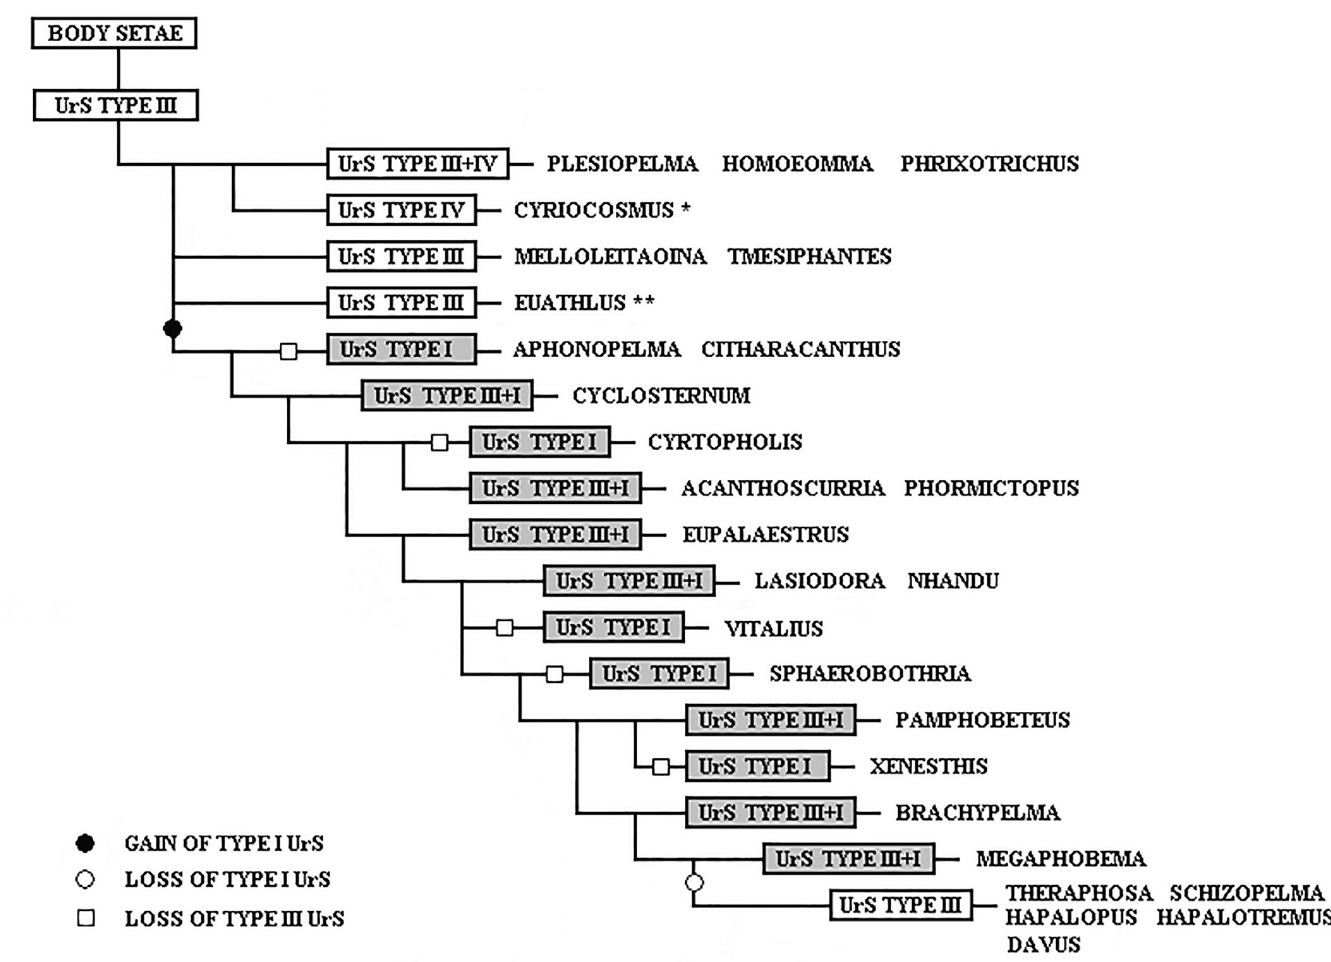
Fig 17. Hypothesis of urticating setae evolution based on the modified cladogram by Pe´rez-Miles et al. [18] and the results presented by Bertani & Guadanucci [9]. Remarks: � Cyriocosmus possesses only type III setae instead of type IV. �� In Euathlus , type III setae occur together with type IV.